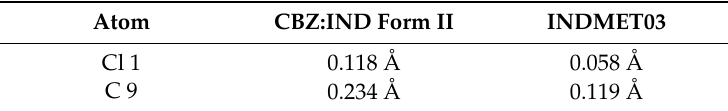
Figure 5. The crystal structure of CBZ:IND form II, viewed down the a -axis. The hydrogen bonds shown as dashed blue lines correspond to the ones indicated in Figure 3b. Table 4. Distances of atoms Cl1 and C9 to the mean plane of the C10–C11–C12–C13–C14–C15 benzene ring for the final CBZ:IND structure reported here and the INDMET03